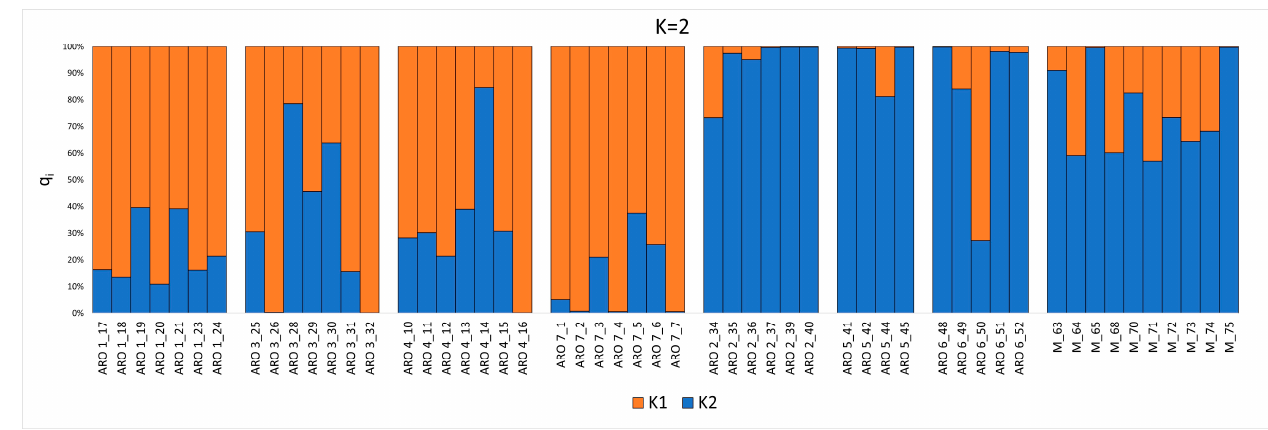
Figure 2 . STRUCTURE bar plots referring to 53 onion individuals genotyped in this study for two ancestral subpopulations (K = 2). Each bar refers to an individual and is colored according to the proportion of the genome (q i ) associated with each K detected .